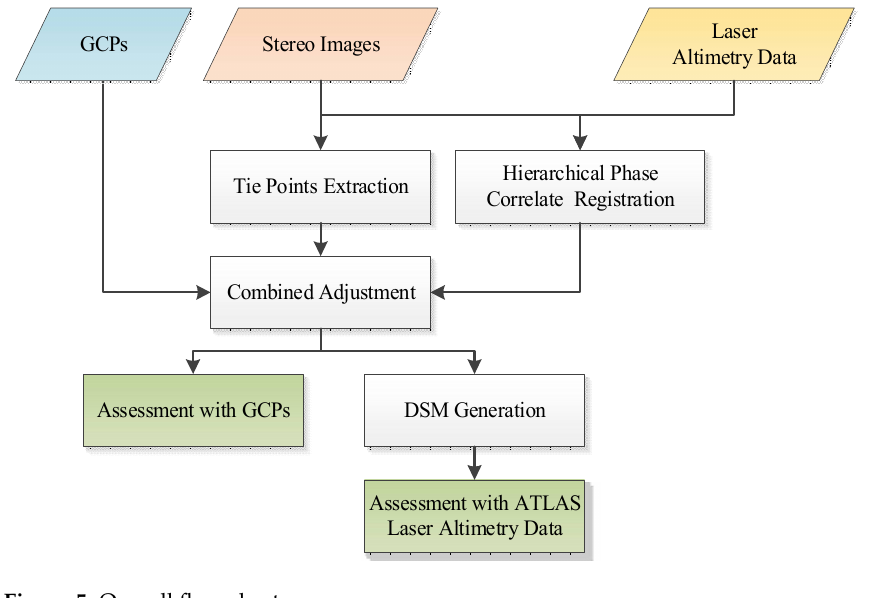
Figure 5. Overall flow chart.